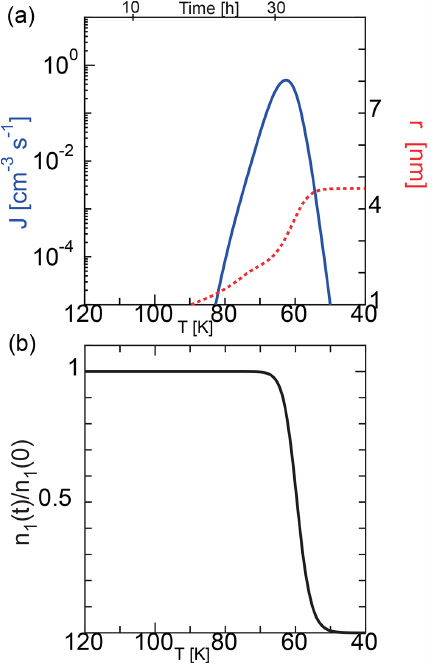
Figure 2. Time evolution of the nucleation rate and mean particle radius during homogeneous nucleation (a) and the ratio of the num- ber density of water molecule to the initial value (b) calculated us- ing the SP model. The initial temperature was 135K, and the cool- ing rate was 3 . 6Kh − 1 .